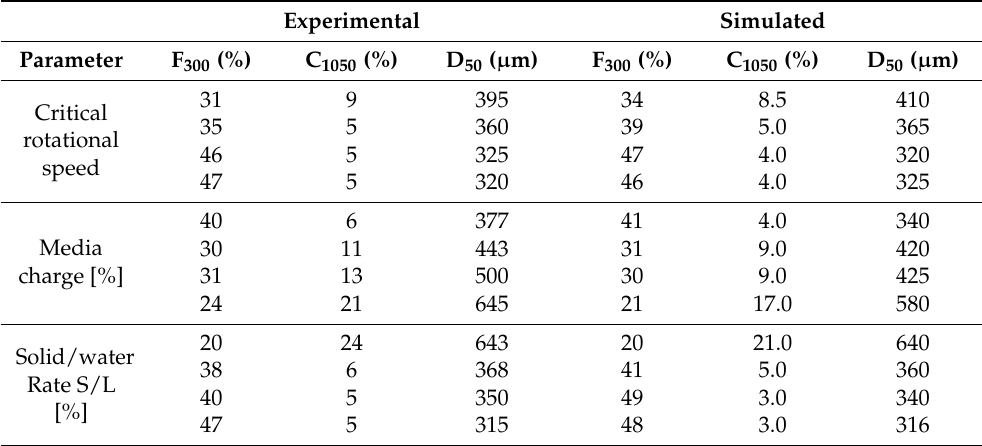
Figure 8. Partial results of the numerical simulation compared with experimental particle size distribution, where ( A ) experimental values of the tests varying the grinding media charge, ( B ) experimental values of the tests varying the slurry solid/liquid ratio, ( C ) simulated values of the tests varying the grinding media charge, ( D ) simulated values of the tests varying the slurry solid/liquid ratio, ( E ) simulated and experimental values of the tests when the solid flow is varied, and ( F ) behavior of the kinetic function S. Table 7. Comparison between experimental key values and simulated parameters using particle size distribution prediction model.